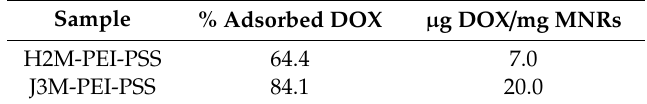
Table 4. Quantification of the doxorubicin adsorbed onto the coated magnetic MNRs (drug loading). Sample